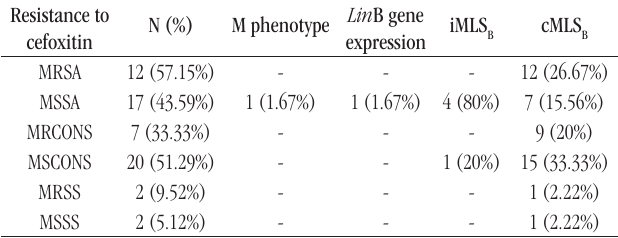
resistance phenotypes of 60 strains of taBLE − MLS B